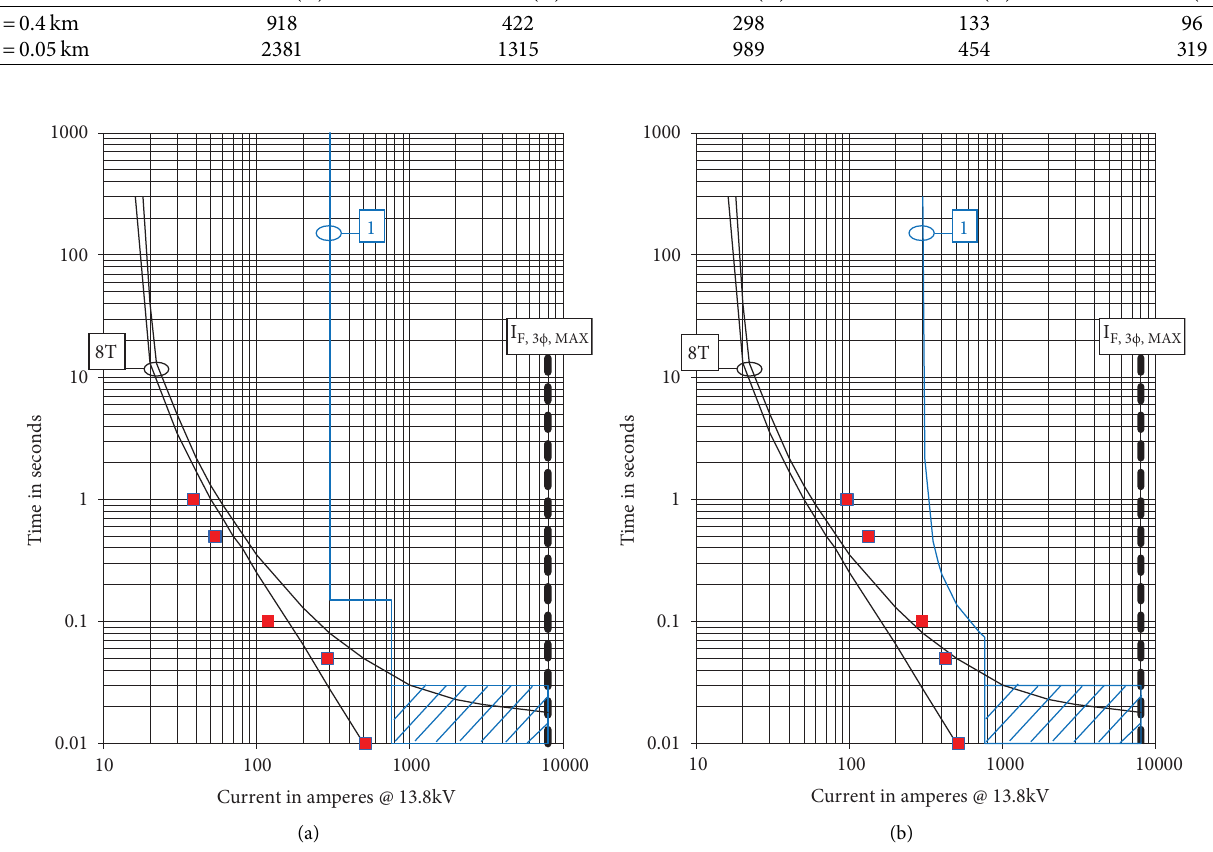
Figure 8: Example of solutions for d � 0.4km; (a) with defnite-time overcurrent function (pickup: 300A; delay: 0.15s); (b) with inverse- time overcurrent function (IEC standard inverse curve; pickup: 300A; time multiplier: